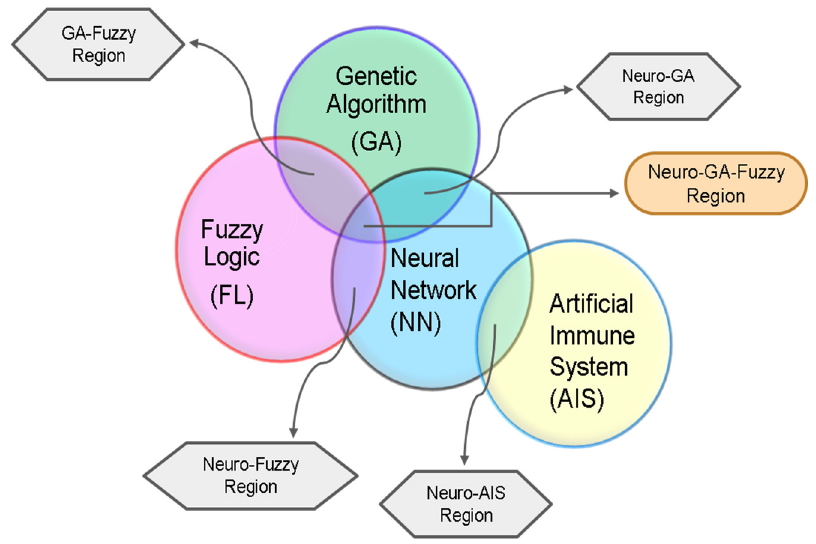
Figure 8. Integration of deep learning with fuzzy logic, genetic algorithm, and artificial immune